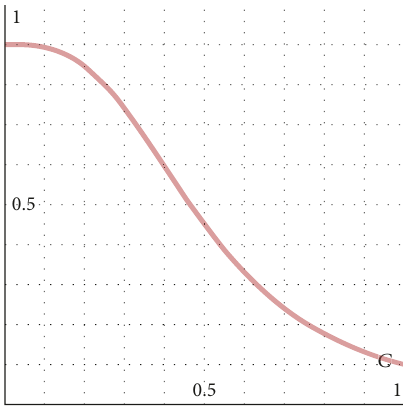
Figure 3: A typical profile of 𝑓 1 (𝑐) with 𝐾 𝑃 = 0.9 , 𝑚 1 = 3 , and 𝑐 = 0.5 𝑐𝑟𝑖𝑡1